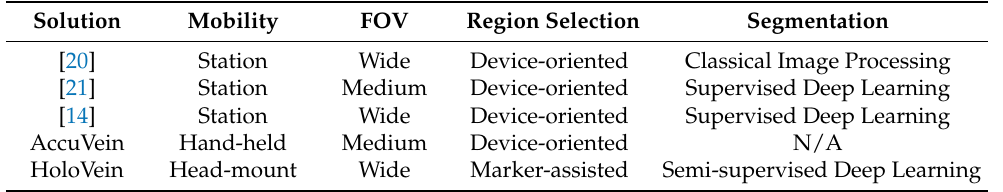
Table 1. Comparing between select NIR-based solutions and the HoloVein system.